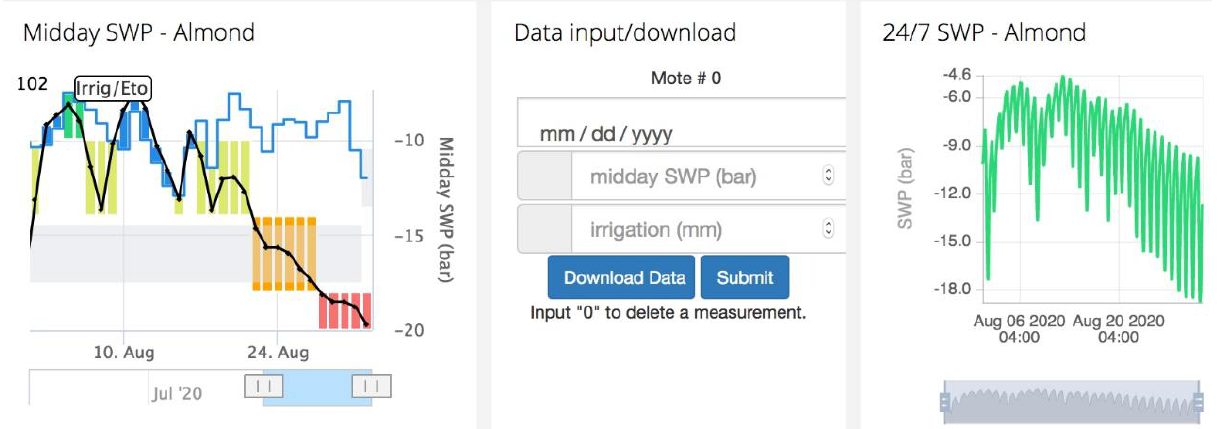
Figure 3. Example of the FloraPulse user interface. At the ( left ) is a plot of only mid-day minimum stem potentials with color-coded indications of relative stress levels. On the ( right ) is a plot of all data which can be downloaded. In the ( middle ) section is where irrigation amounts, and times and manual stem potentials can be added to the database.